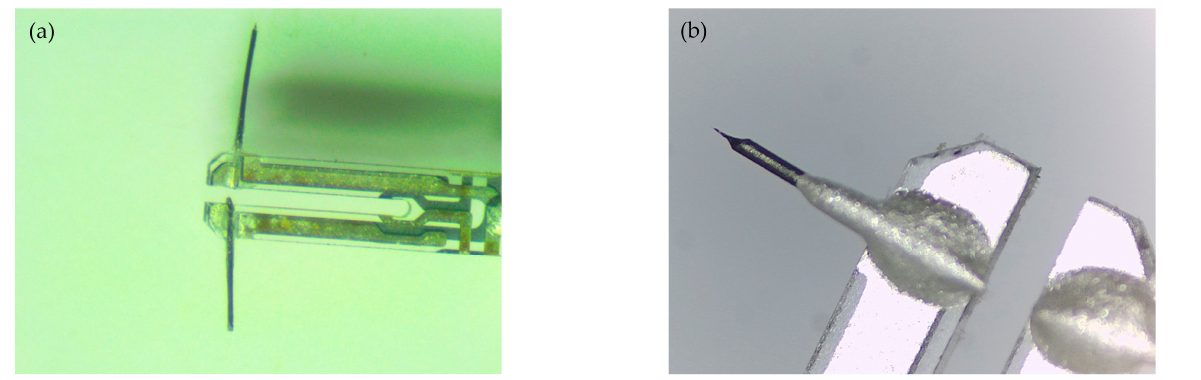
Figure 7. Photos of a quartz tuning fork probe: ( a ) Quartz tuning fork arm for bonding tungsten wire; ( b ) probe tip after electrochemical corrosion.